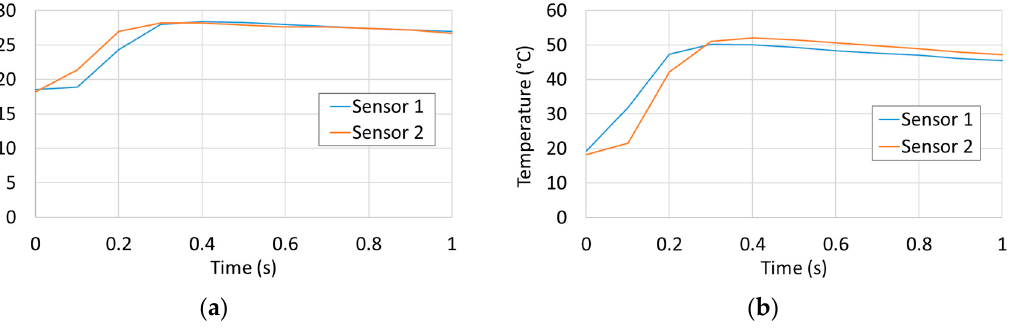
Figure 17. Temperature measurements for 316L, D3, UHCF specimen: ( a ) Maximum stress = 271 MPa, t on = 0.11 s, 1 pulse; ( b ) Maximum stress = 350 MPa, t on = 0.11 s, 1 pulse.